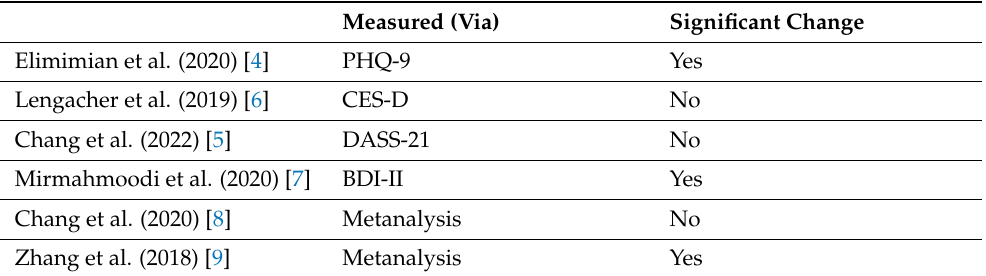
Table 12. Depression Outcomes